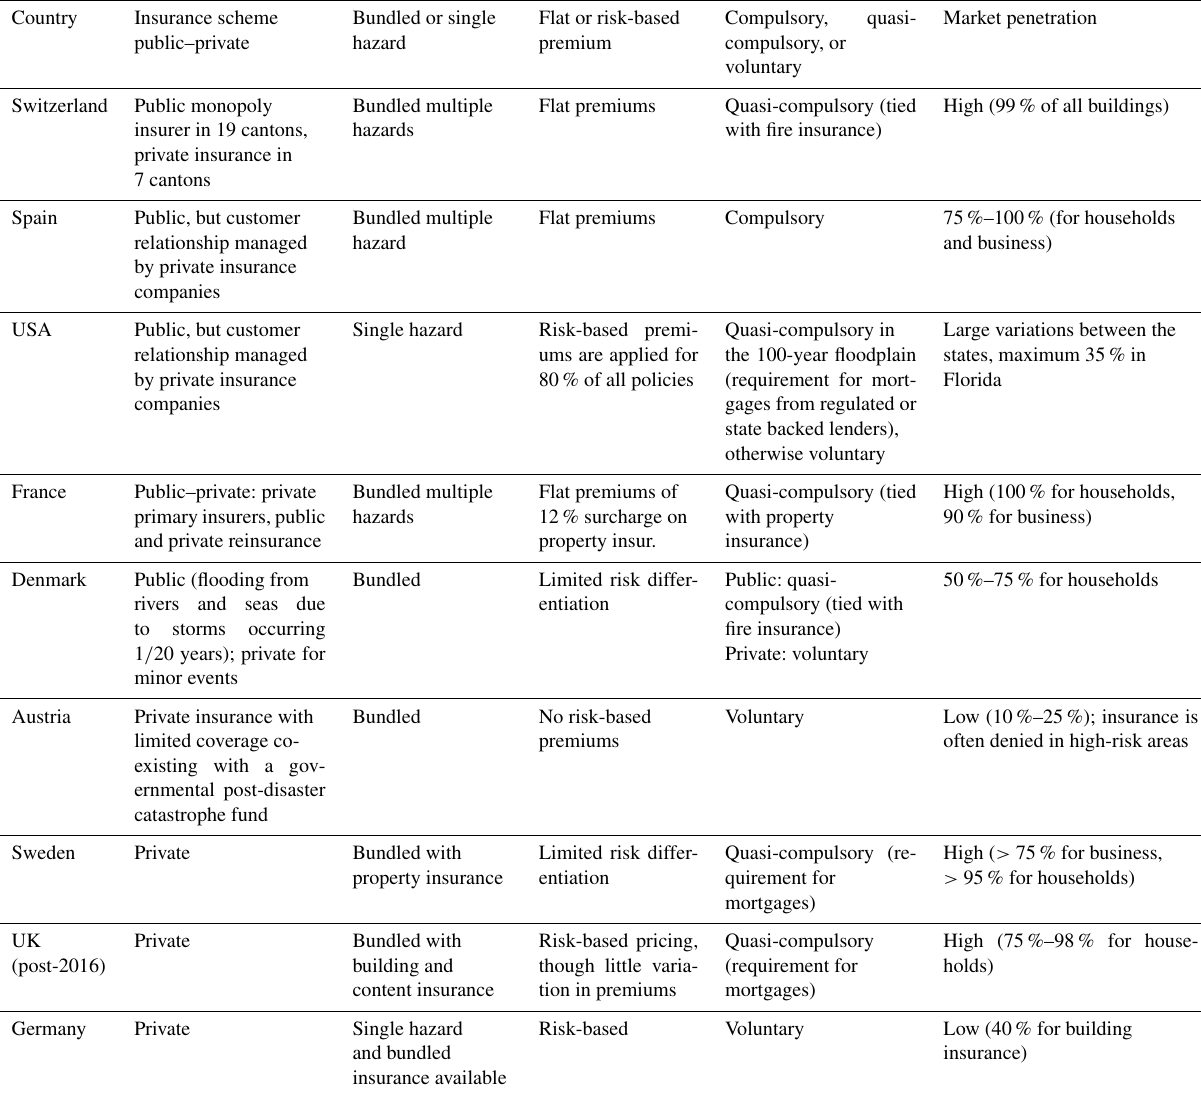
Table 1. Overview of insurance schemes and flood insurance conditions for household and business insurance in several countries, depicting the range from public to private insurance schemes. (Information in this table was derived from Atreya et al., 2015; Den et al., 2017; Guillier, 2017; Hanger et al., 2018; Kousky, 2017; Kousky et al., 2016; Priest et al., 2016; Surminski and Eldridge, 2015; Surminski and Thieken,